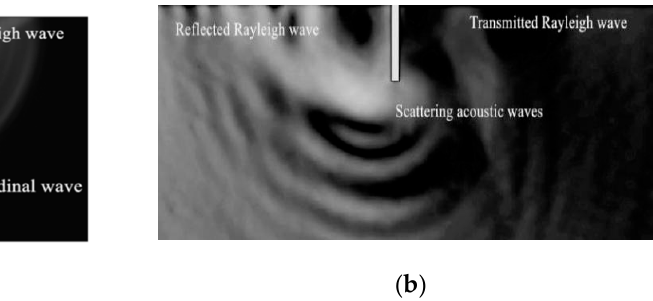
Figure 4. The energy distribution of the acoustic signals.